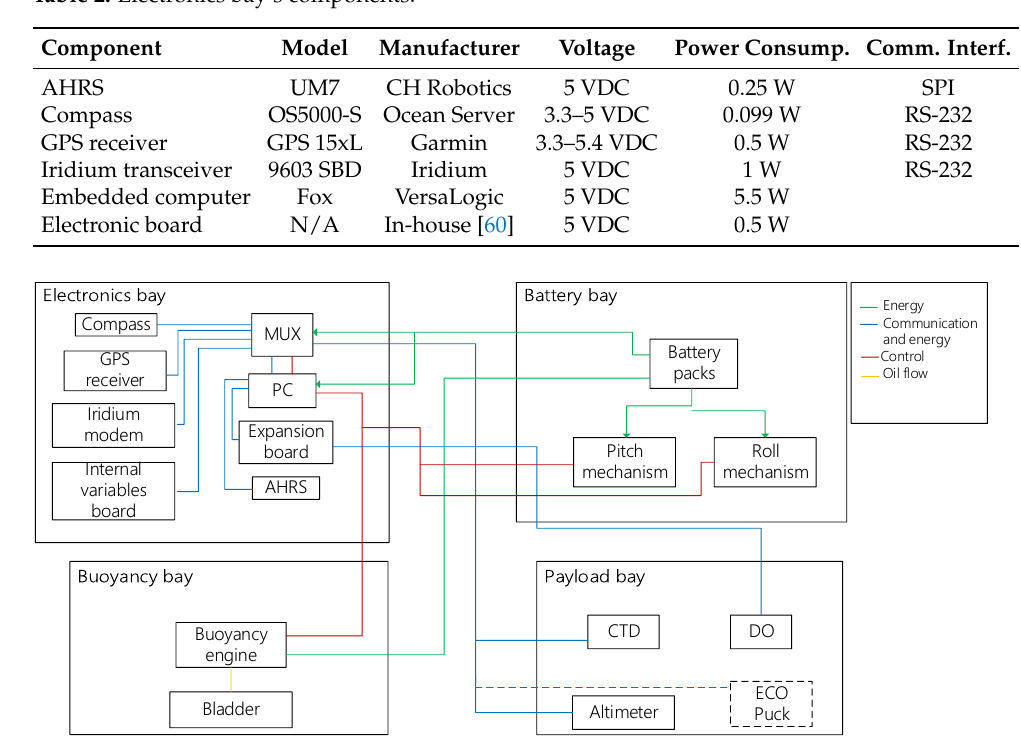
Figure 12. Distribution of electronics ( a ), batteries ( b ), and buoyancy ( c ) bays. Table 2. Electronics bay’s components.